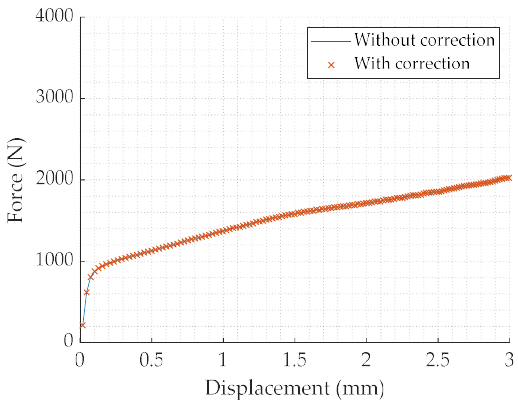
Figure 4. Force–displacement curve of a compression test on a lead alloy sample, at 0.01 s −1 room